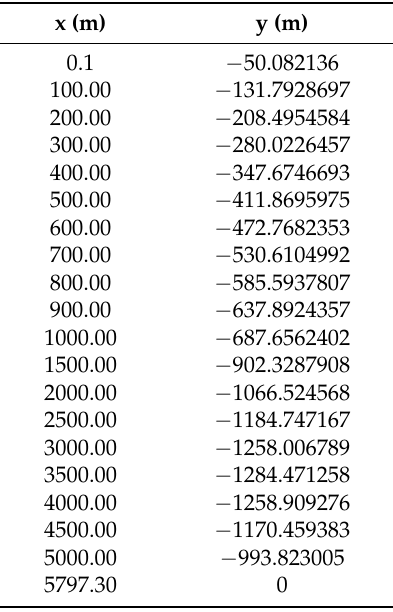
Table 6. The borders of the contaminated plume along axes x and y in the case of the carcinogenic risk for adults. x (m) y